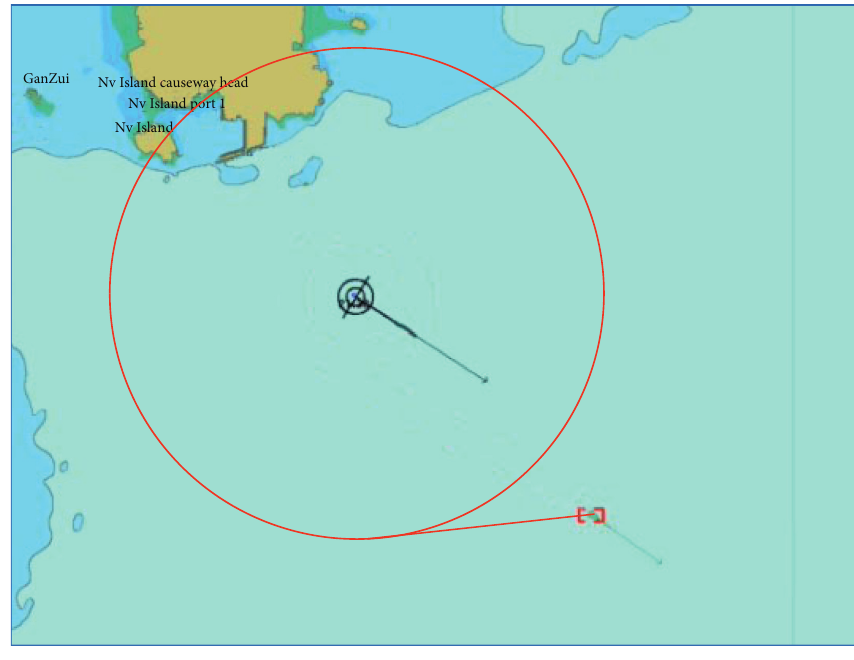
Figure 22: Right-steering collision avoidance.